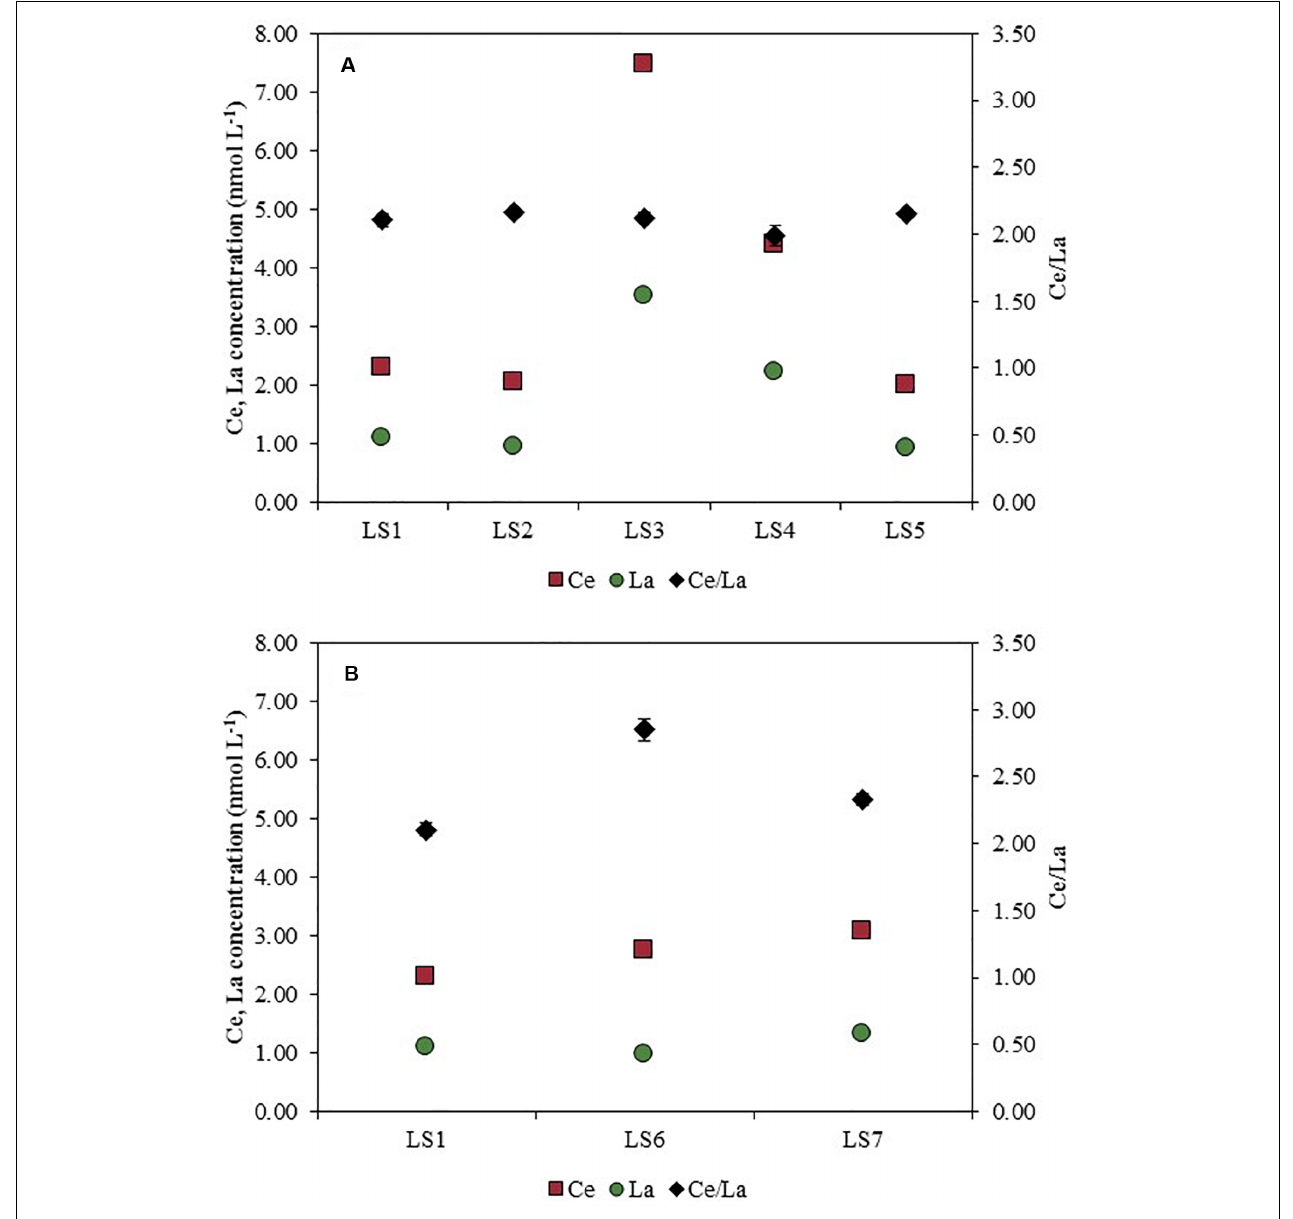
FIGURE 5 | Total Ce and La concentrations (left-hand side axis) and Ce/La ratios (right-hand side axis) along (A) Orleans city (LS1 to LS5) and in (B) the outdoor activities center (LS6 and LS7 compared with LS1) after an acid digestion.